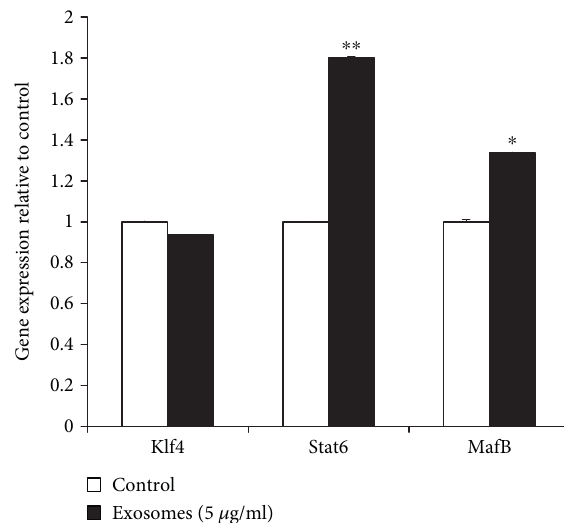
Figure 5: AdMSC-derived exosomes activate macrophage M2 polarization-related transcription factors. PBMCs treated with exosomes showed signi fi cant e ff ects on the activity of transcription factors Stat6, MafB, and Klf4 of M2 macrophages. The data are expressed as the mean ± SD of three independent experiments. ∗ P ∗∗ P < 0 : 05 , < 0 : 01